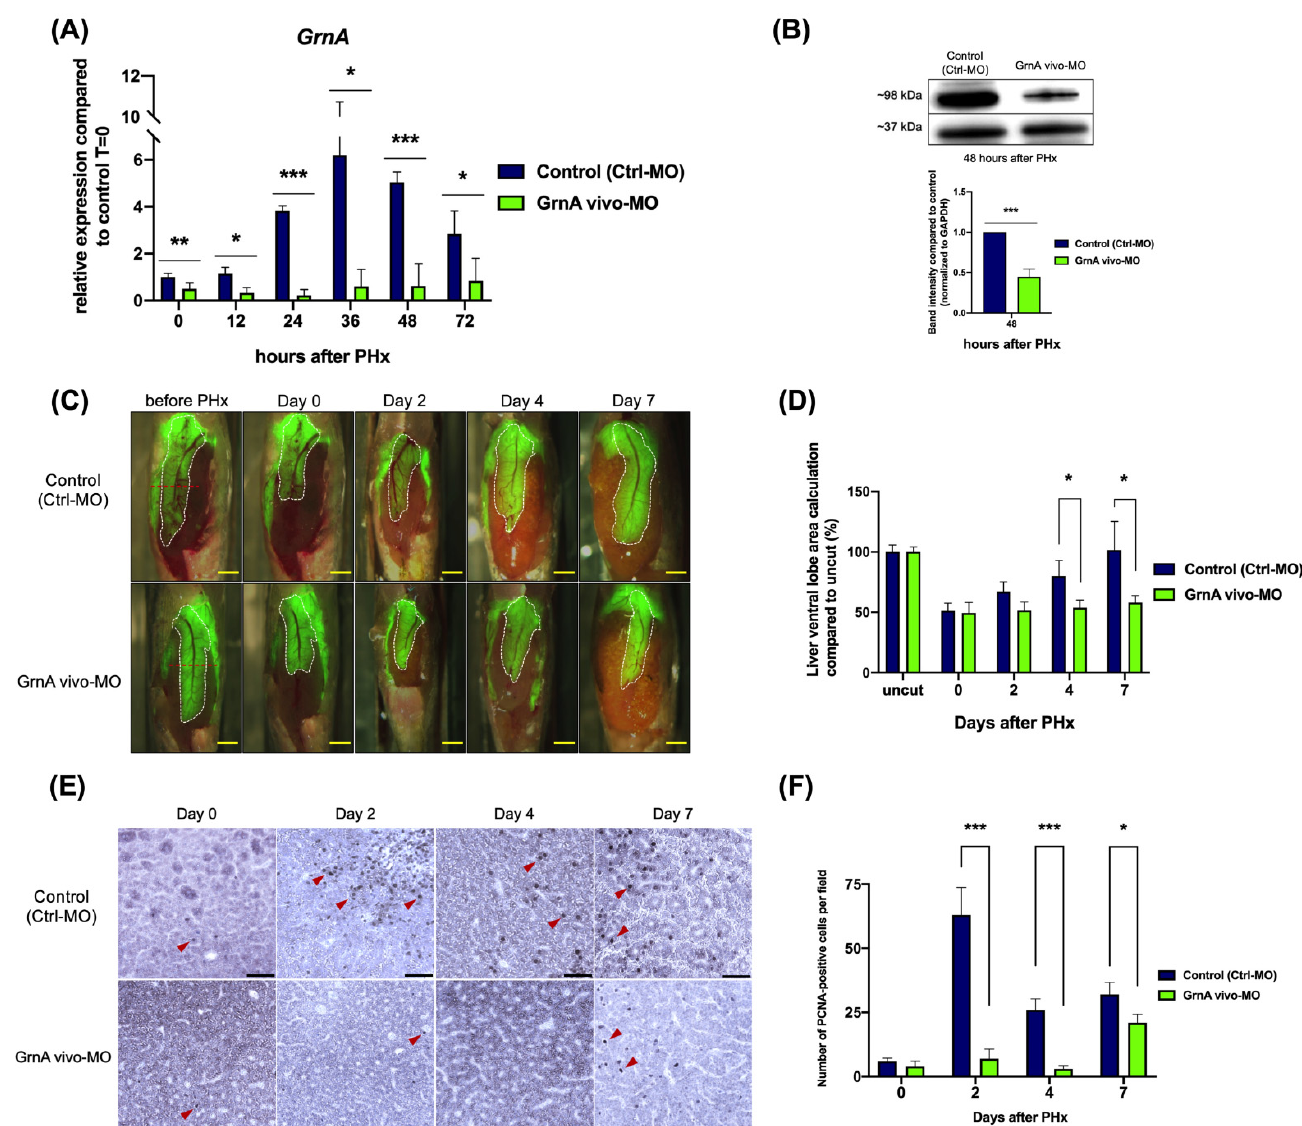
Figure 2. GrnA morphant exhibited impaired liver regeneration after PHx. ( A ) GrnA gene expression was examined by quantitative PCR after PHx. The relative expression levels are presented as mean ± SD, compared to control group at 0 h PHx. ( B ) Protein levels of GrnA and GAPDH were examined by Western blot analysis at 2 days after PHx. GrnA protein levels were normalized to GAPDH and then fold-change was calculated compared to control group. The values are presented as mean ± SD. ( C ) Partial hepatectomy in control ( upper ) and GrnA morphant ( lower ) was carried out on day 0. The regenerating liver ventral lobe is shown at 2, 4, and 7 days after PHx. White dotted line indicates liver ventral lobe. Red dotted line shows the site of PHx. Scale bar: 1 mm. ( D ) Liver ventral lobe area after PHx is shown in ( C ). The area was normalized to control uncut group and presented as percentage; mean ± SD. ( E ) Immunohistochemical staining of PCNA in liver ventral lobe at 0, 2, 4, and 7 days after PHx. Red arrowhead indicates the PCNA-positive cells. Scale bar: 50 µ m. ( F ) Number of PCNA-positive cells was quantified after PHx, as shown in ( E ). The data are presented as mean ± SD. Significance was set at * p < 0.05, ** p < 0.01, *** p < 0.001, as determined by t -test; PHx, partial